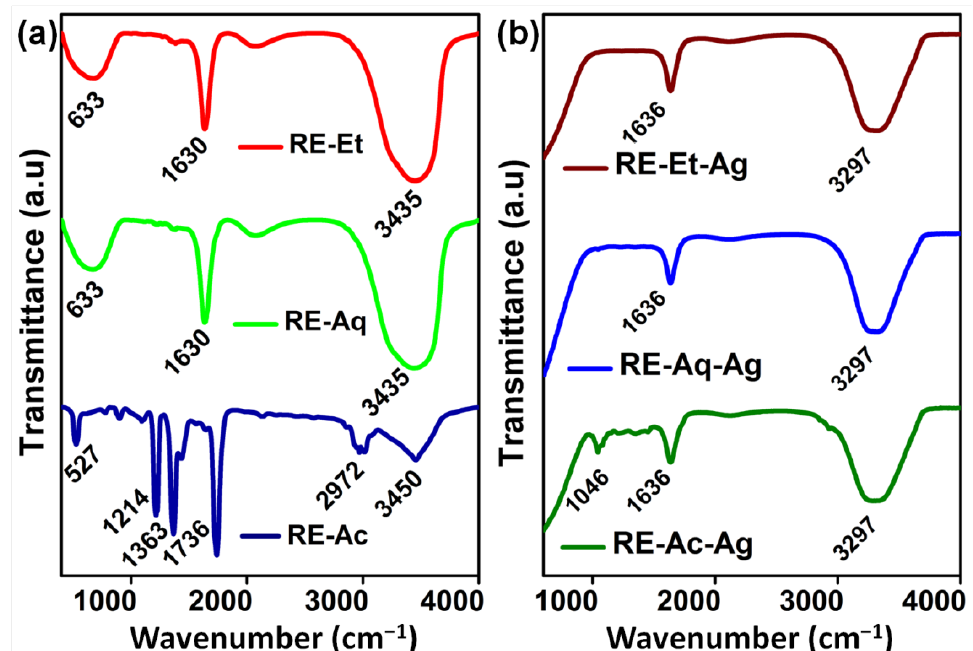
Figure 2. FTIR spectrum of plant extracts: ( a ) RE-Ac, RE-Aq, and RE-Et; ( b ) AgNPs RE-Ac-Ag, RE-Aq-Ag, and RE-Et-Ag.